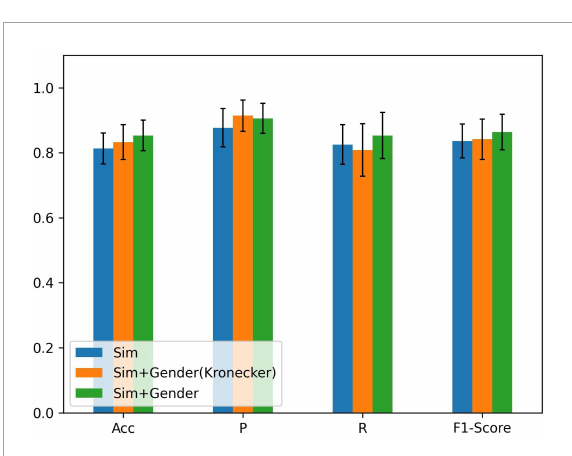
this graph, demographic characteristics (gender, height, weight) were further added to compare their performance separately.